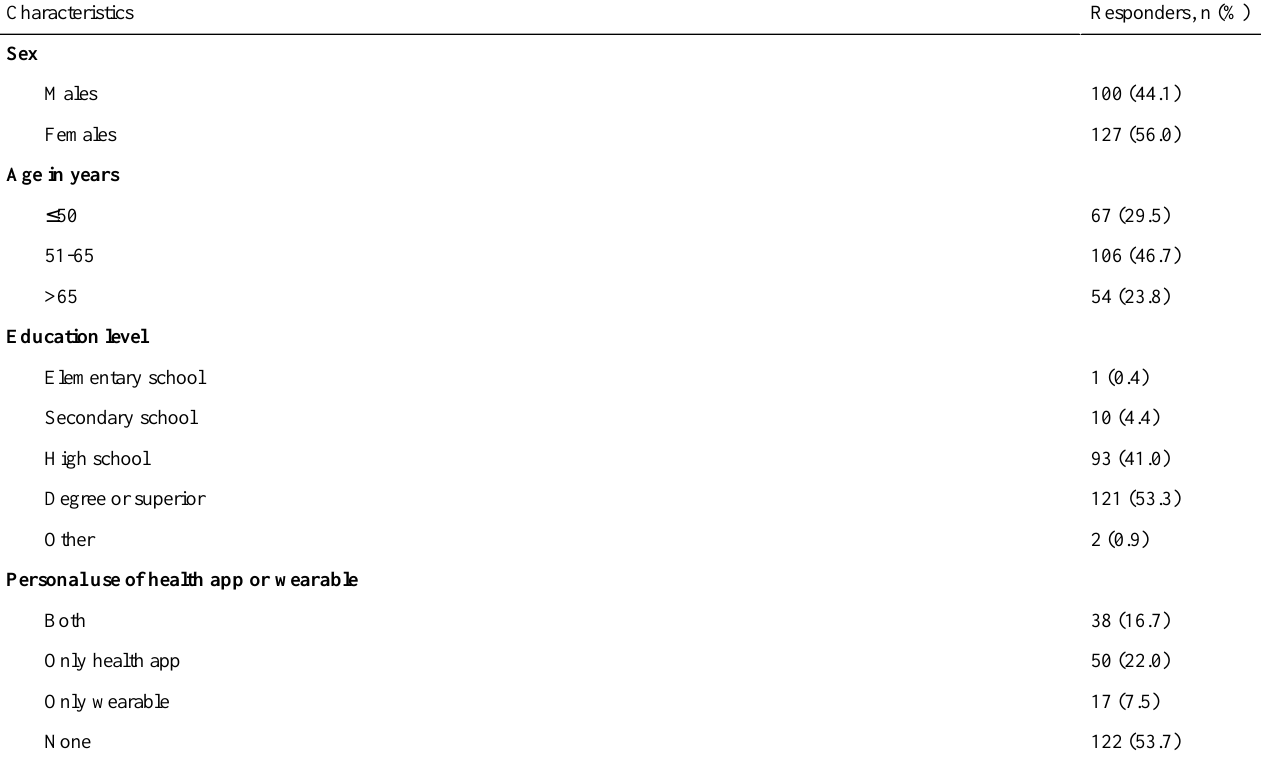
Table 2. Characteristics of responders (N=227).